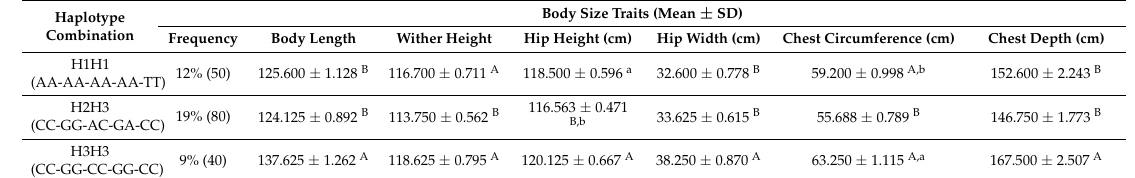
Table 6. Associations of haplotype combination with body size traits in Qinchuan